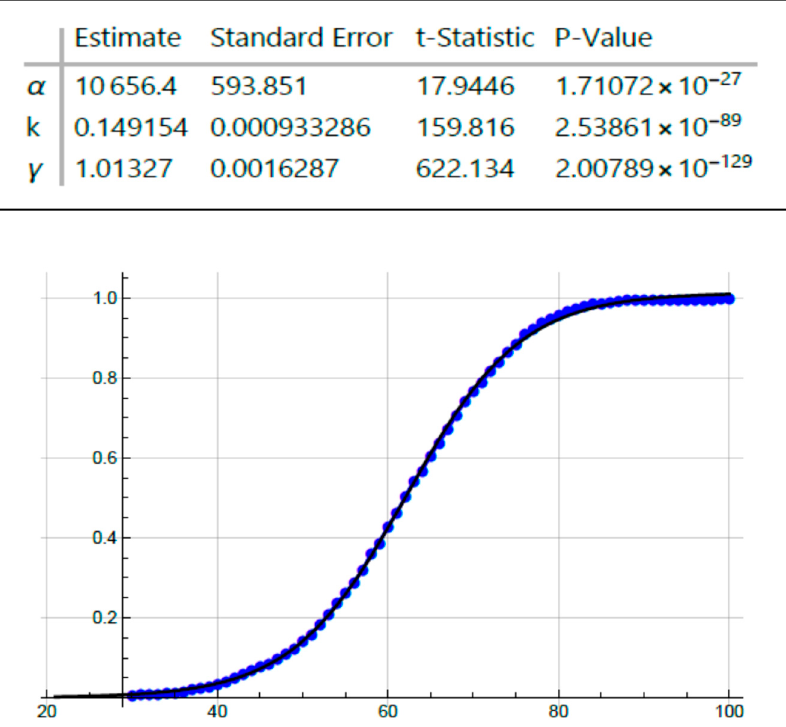
Figure 5. Fitting age-at-colorectal cancer (CRC) diagnosis data on FAP patients using the logistic equation.